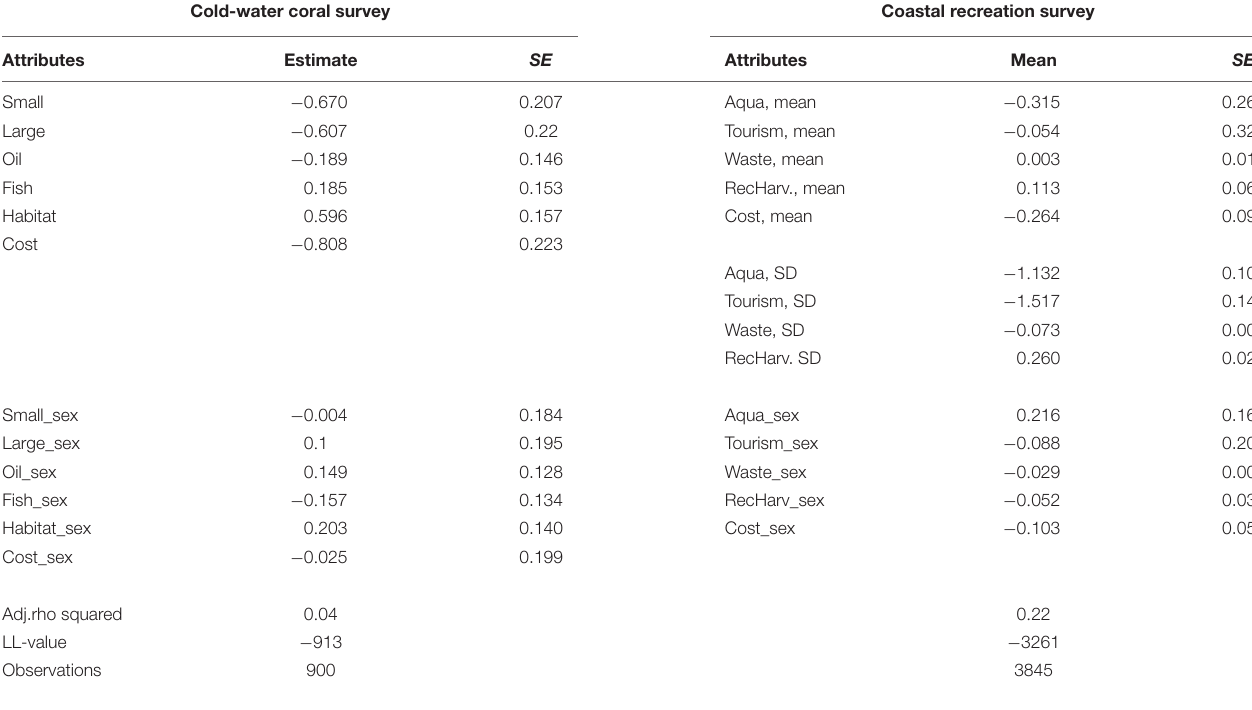
TABLE A5 | Results for model with socio-demographic interaction for gender. Cold-water coral survey Coastal recreation